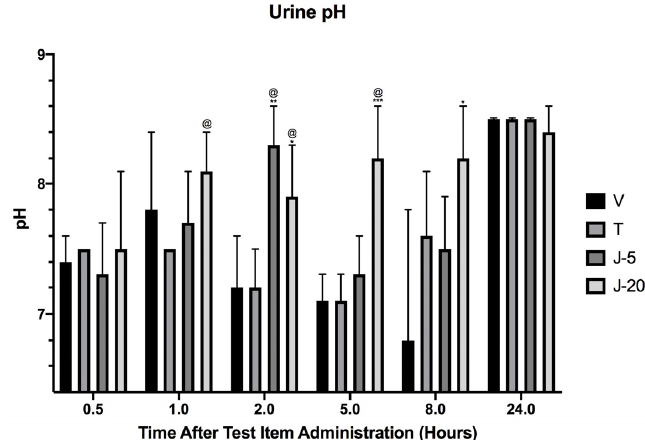
Figure 3. Average urine output measured at 30 mins and 1hr, 2hr, 5hr, 8hr and 24hrs after single oral or intravenous treatment. Analysis was performed with two-way ANOVA followed by Dunnett’s post hoc test against saline control (V); Statistical significance: *p < 0.05, ** p < 0.01, *** p < 0.001. Groups: V: saline vehicle, 0.2 mL, PO; T: Tolvaptan, 30 mg/kg, PO; JT09-5mg/kg (J-5): 5 mg/kg, PO; JT09- 20mg/kg (J-20): 20 mg/kg, PO. Data are expressed as mean ± standard deviation with n =